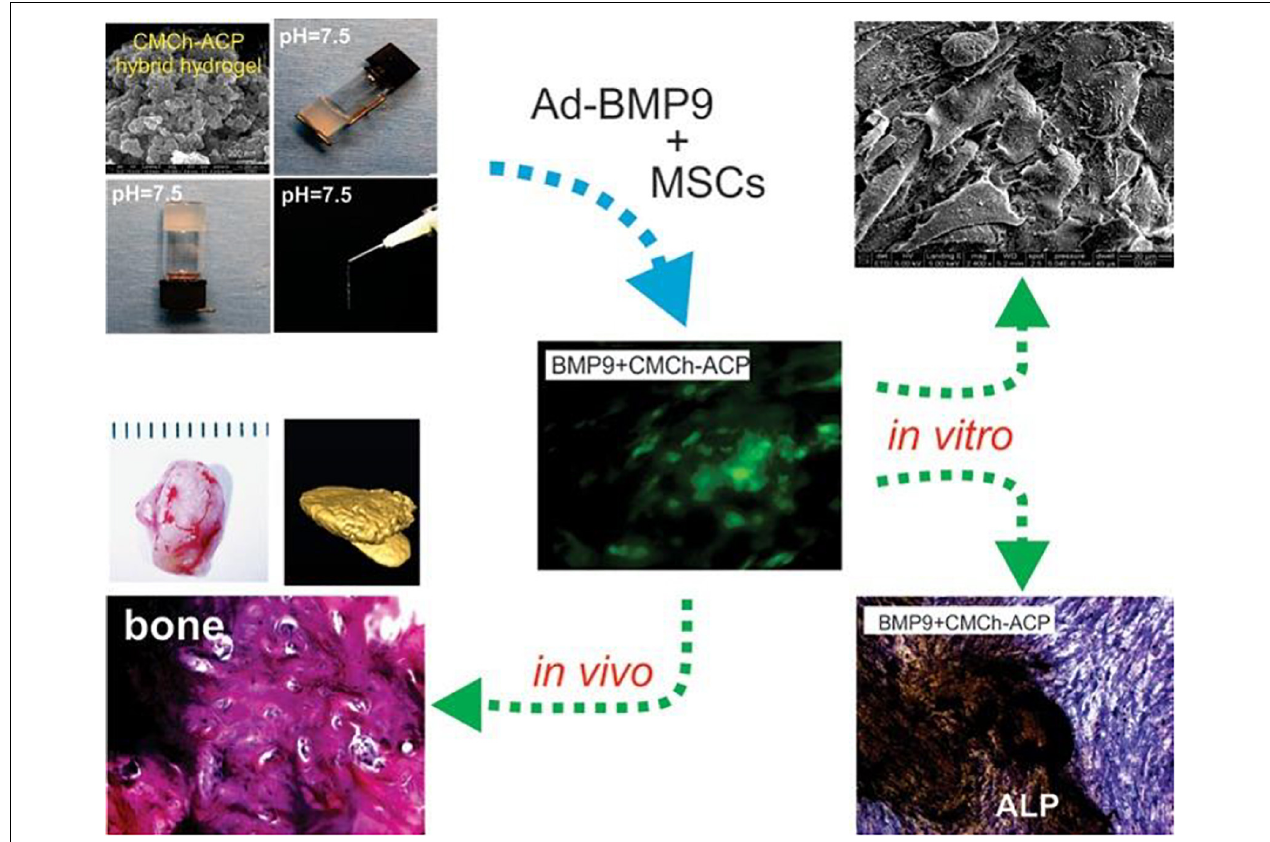
FIGURE 3 | Schematic representation of pH-responsive CS-based hydrogels for bone tissue engineering. Reproduced from Zhao et al. (2019) with permission from Copyright 2019 American Chemical